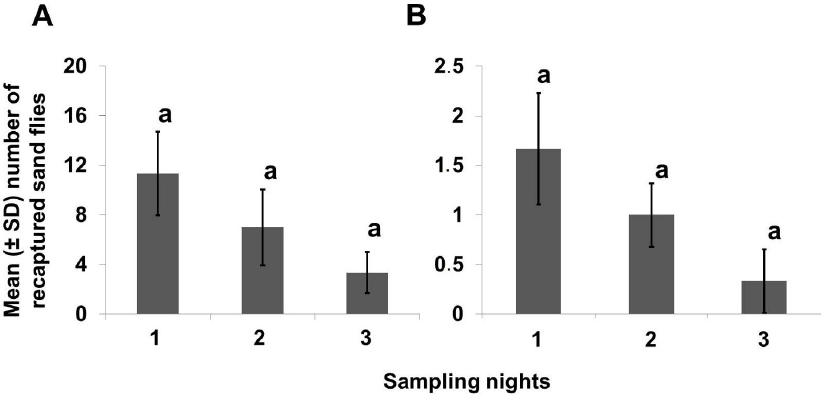
Fig 6. Number of recaptured Lu . longipalpis sand flies trapped over each of three consecutive nights in household (A) and household (B). The mean ± SD sand flies (males + females) for each night was calculated from a total of three replicates (corresponding to the experiments marked with lime + pink fluorescent powders at the three distances). The mean numbers of recaptured sand flies in bars with the same letters were not significantly different from each other ( P < 0.05).